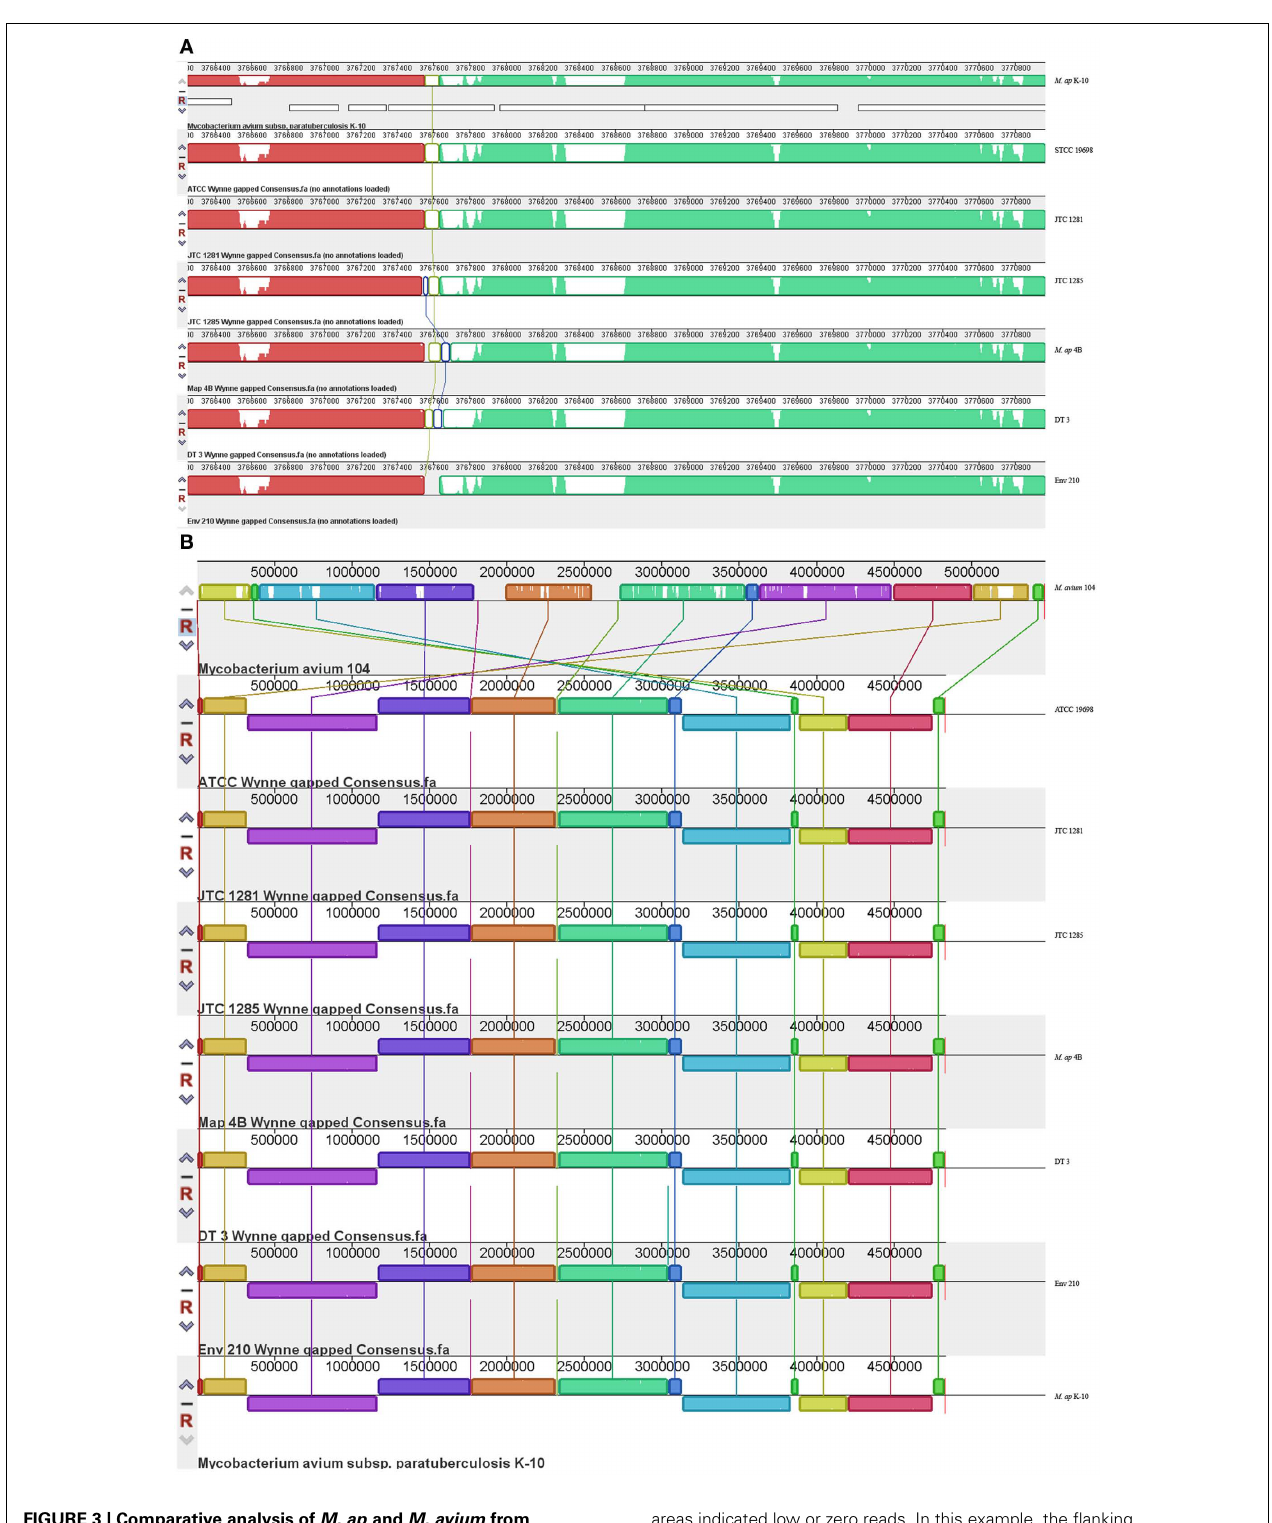
FIGURE 3 | Comparative analysis of M. ap and M. avium from animals and environmental sources. The gapped consensus sequence of each strain was used for comparison by MAUVE version 2.3.1. (A) A close-up depiction of a breaking point in the alignment of six M. ap genomes in comparison to M. ap K-10 reference genome.The white